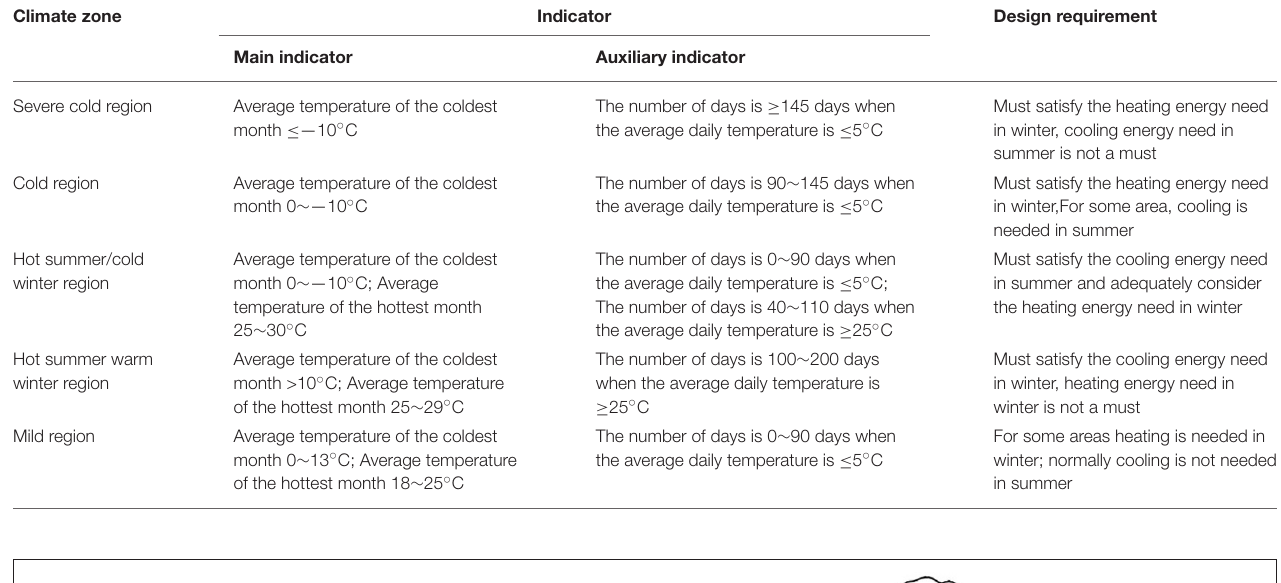
TABLE 3 | Climate zones and design requirements (GB, 1993).